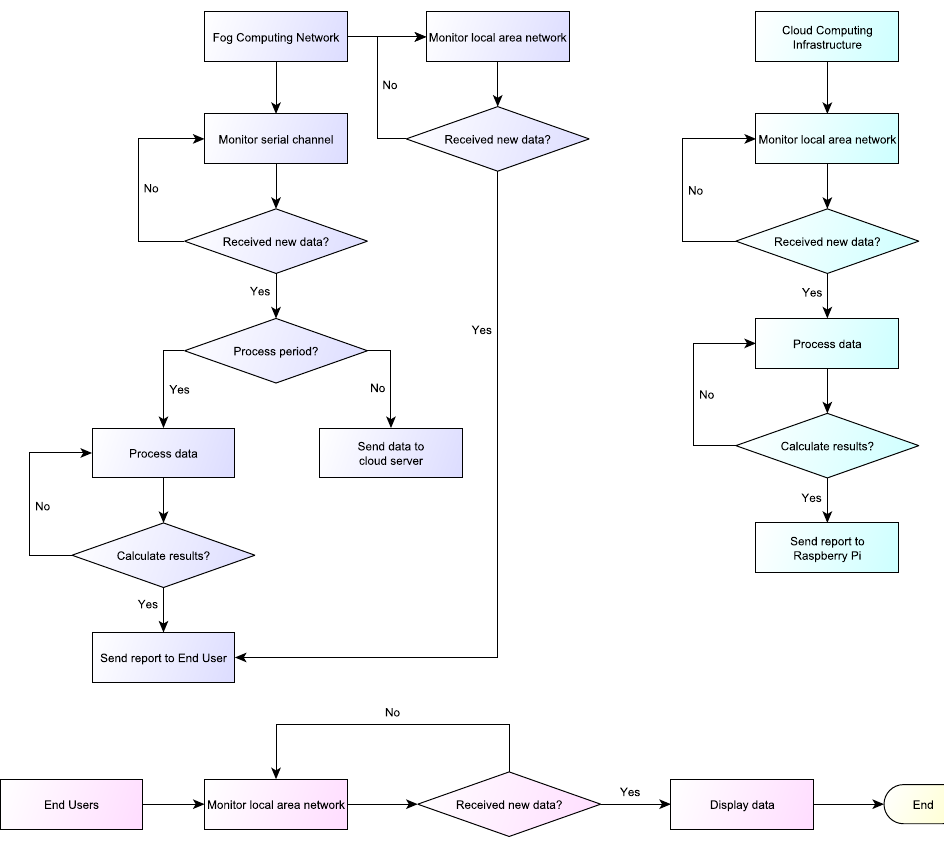
Figure 3. Flow chart of all processes occurring in the cloud/fog side of the proposed